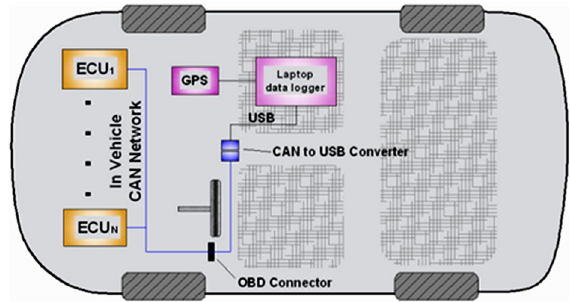
Fig. 2. Layout on-board instruments